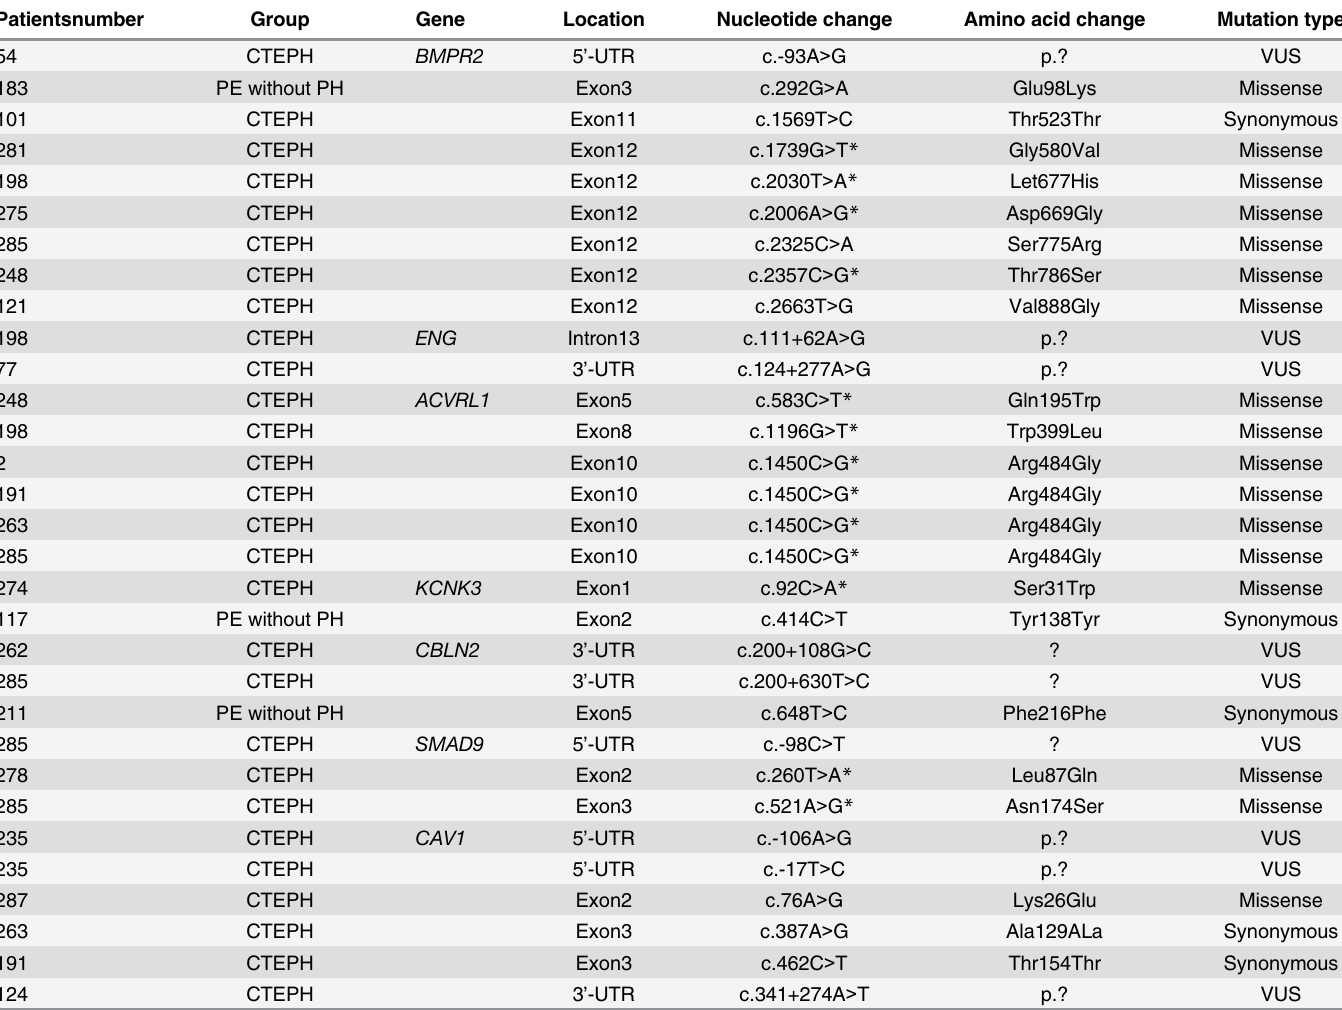
Table 4. Gene mutations in Chinese CTEPH patients and PE without PH patients.